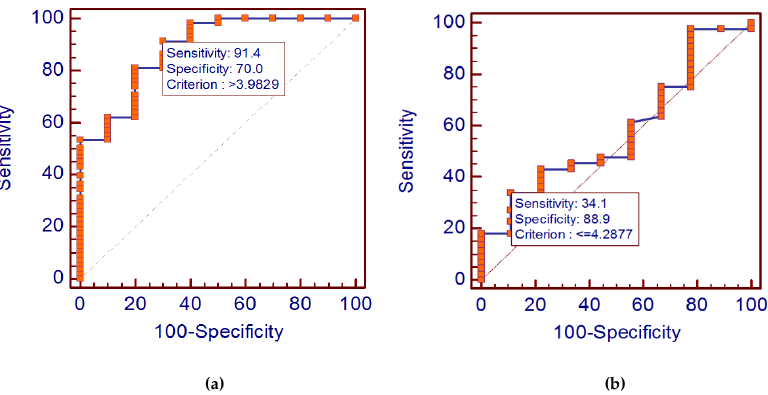
Figure 3. (a) Receiver operating characteristic curve (ROC) for serum cystatin C levels (diagnostic curve) in the fifty eight untreated group of patients. Figure 3. (b) Receiver operating characteristic curve (ROC) for serum cystatin C levels (prognostic curve comparing patients who achieve remission (responders) and patients who did not (non-